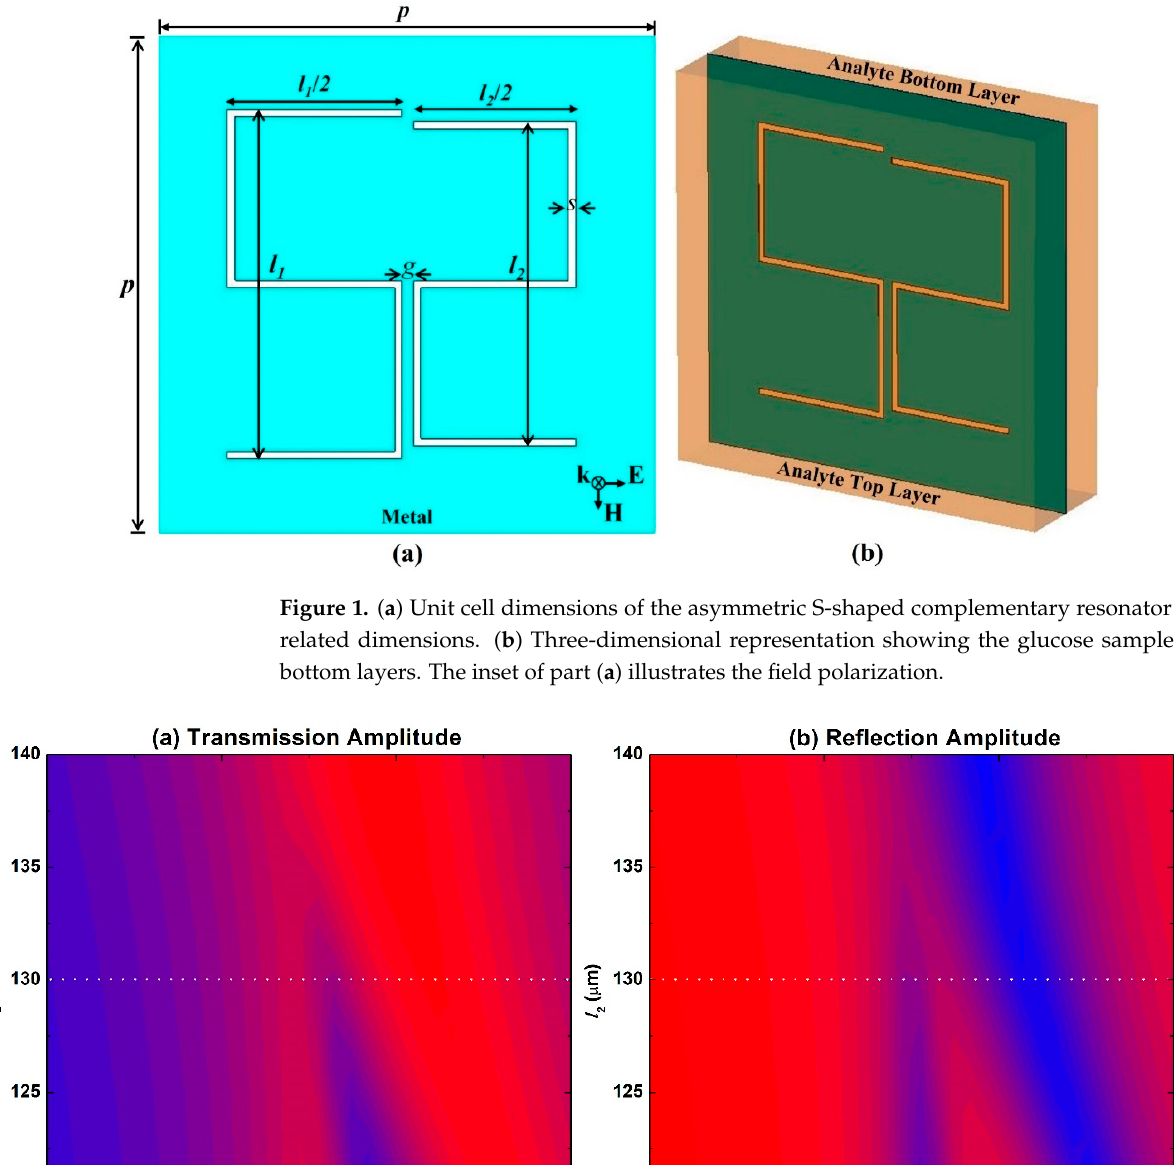
Figure 3. ( a ) Transmission and ( b ) reflection frequency response of the S-shaped complementary metasurface for the symmetric case when l 2 = 140 μ m and the asymmetric case when l 2 = 130 μ m. To get an understanding of the resonance excitation, additional simulations to visu- alize the electromagnetic fields were carried out for both symmetric and asymmetric res- onance frequencies as shown in Figure 4 when l 2 = 130 μ m. It presents the spatial